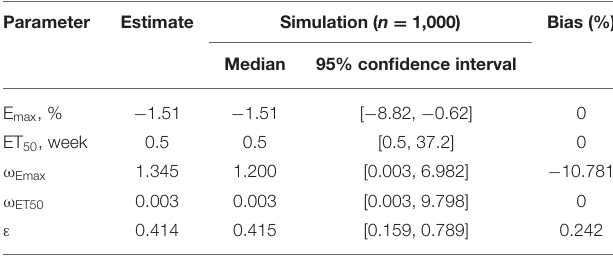
TABLE 2 | Parameter estimates of final model and 95% confidential